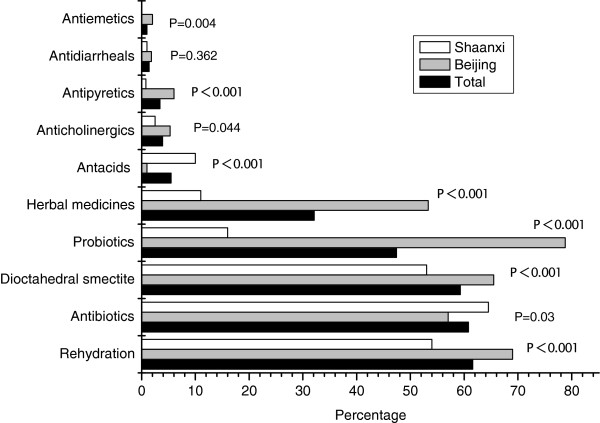
Interventions ordered by treating physicians. p-values refer to comparisons between Beijing and Shaanxi province.